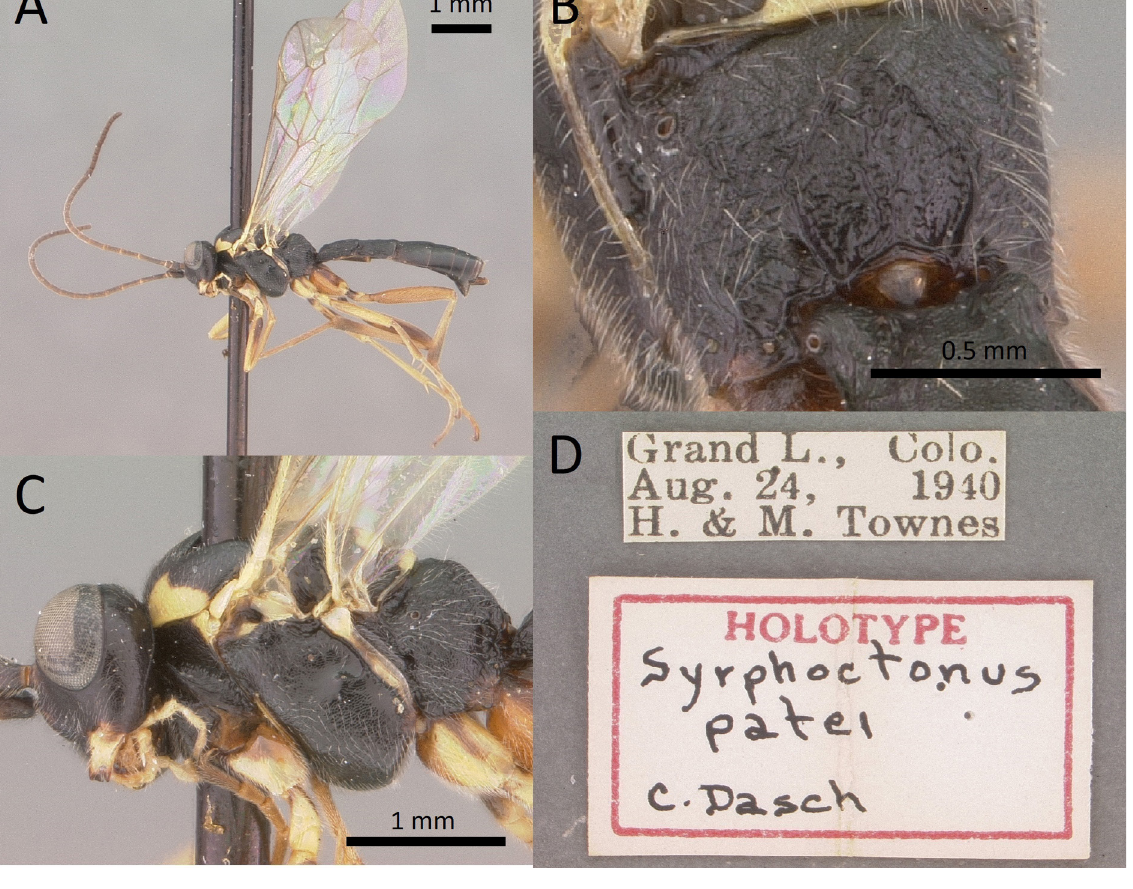
Fig. 11. Woldstedtius patei (Dasch, 1964), holotype, ♀, Colorado, Grand L., 24 Aug. 1940, H. and M. Townes leg. (USUC). A . Habitus, lateral view. B . Propodeum, laterodorsal view. C . Head and mesosoma, lateral view. D . Labels. Photos: David Wahl